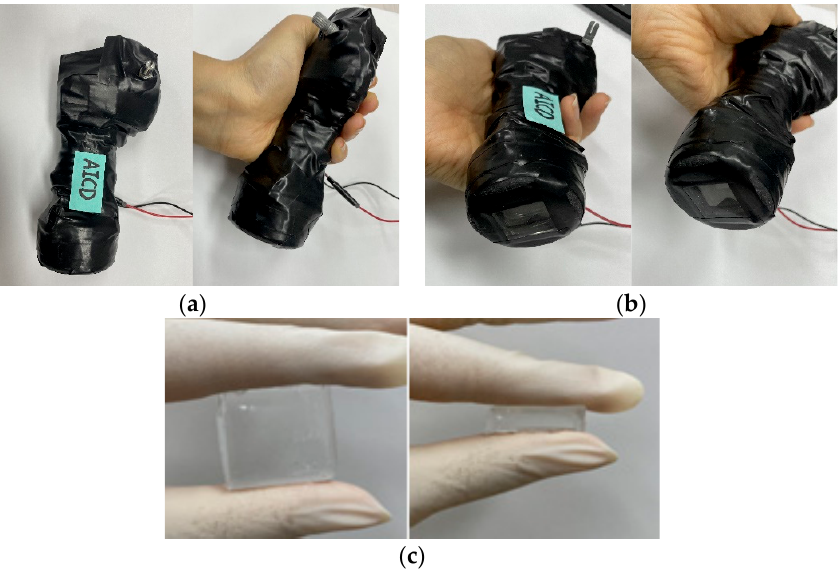
Figure 15. ( a ) Optical tactile-imaging device. ( b ) Bonded site of PDMS. ( c ) Final PDMS photographs.